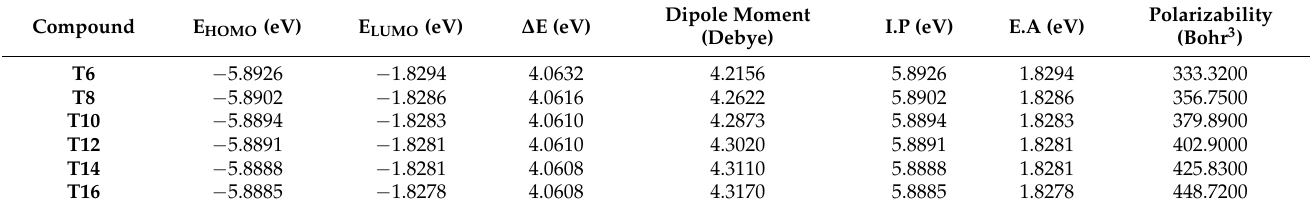
Table 3. Reactivity and polarity parameters of the Tn series calculated at the B3LYP/6–31g(d,p) level. Compound E HOMO (eV)